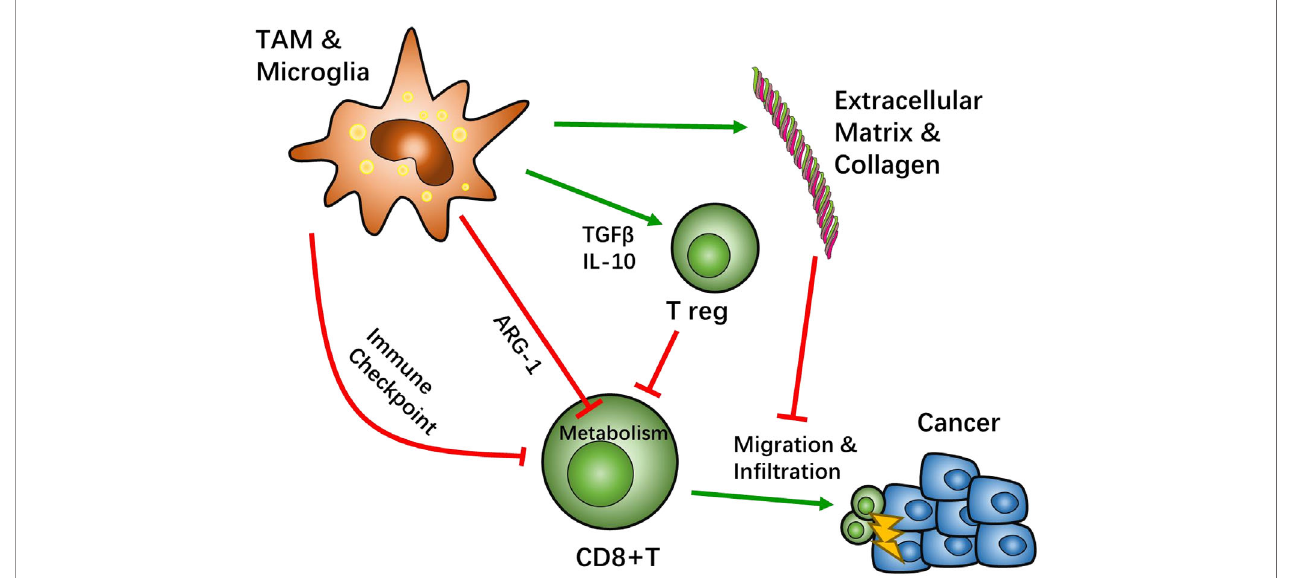
FIGURE 1 | Crosstalk between tumor associated macrophages (TAMs) and CD8-positive (CD8+) T cells. Most TAMs function as tumor suppressive agents. TAMs create an immunosuppressive microenvironment through a sophisticated network. The classical pathway to inhibit CD8+ T cell function is through immune checkpoint recognition. TAMs present immune inhibition signals, such as programed cell death protein (PD-1) pathway or cytotoxic T-lymphocyte-associated protein 4 (CTLA4) pathways, which hamper CD8+ activation. TAMs also recruit other immunosuppressive cells, such as regulatory T cells (Treg), by secreting IL-10 and TGF b to negatively regulate CD8+ T cells. Studies suggest that the metabolism of CD8+ T cells can be affected by TAMs. Speci fi cally, TAMs can lead T cell starvation though arginine metabolism. After activation of CD8+ T cells, TAMs can help in fl uence the migration and in fi ltration of CD8+ T cells through extracellular matrix stiffness and collagen deposition to have an effect on